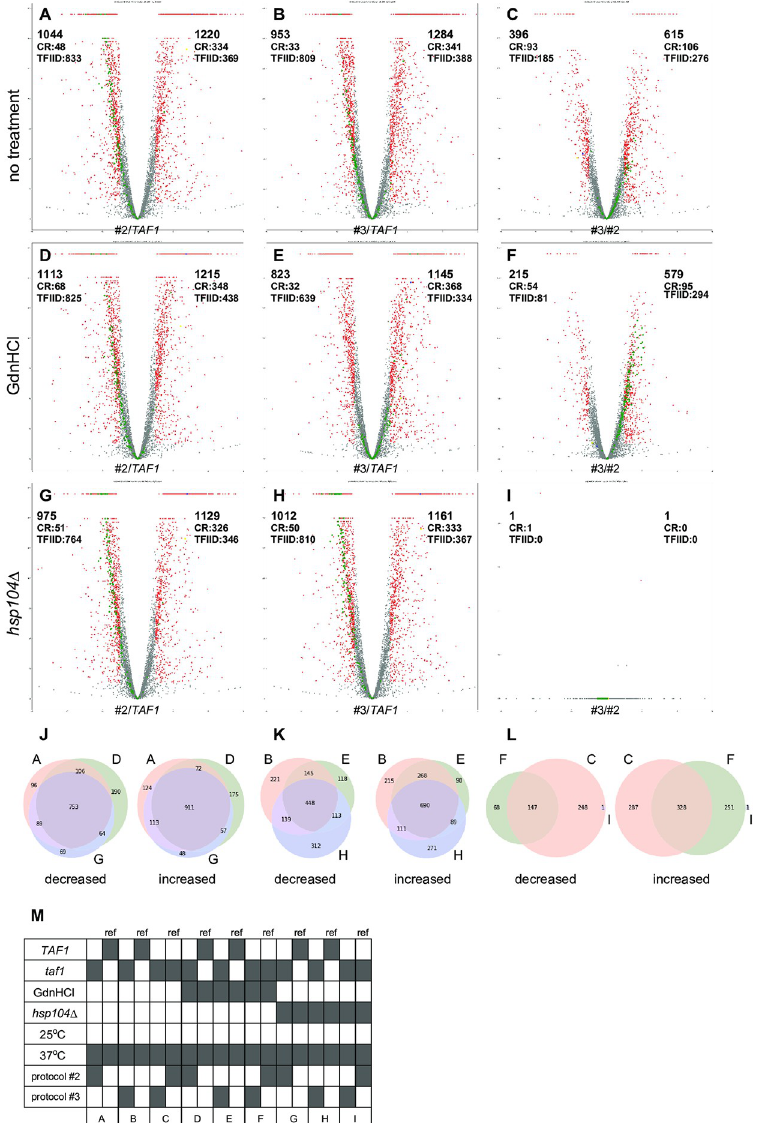
Fig 4. Volcano plot analyses of the gene expression profiles of #2 and #3 strains reveal HSP104 dependency of differential gene expression. TPM data of the RNA-seq analyses obtained from two biological replicates of six strains with and without taf1 or hsp104 Δ mutations after cultivation under various conditions, which are indicated in the bottom panel, were averaged and subjected to volcano plot analyses. Fold changes of gene expression in the #2 strain or #3 strain relative to that in the TAF1 strain are shown in A and B, respectively. Similarly, fold changes of gene expression in the #3 strain relative to that in the #2 strain are shown in C. The analogous three sets of comparisons were conducted for the TPM data derived from strains cultivated in the presence of Gdn-HCl (D, E, F) or the hsp104 Δ mutation (G, H, I). In A–I, the genes considered to be significantly differentially expressed ( > 2-fold change, p < 0.05) are indicated with red dots, while ribosomal protein genes, ~95% of which are TFIID-dependent genes [10], are indicated with green dots. Furthermore, the numbers of class II genes or those of the subclasses CR or TFIID- dependent, that were significantly differentially expressed, are shown in the upper left or upper right corners of A–I. The overlaps among these differentially expressed class II genes across A, D, and G (#2 strain versus TAF1 ), B, E, and H (#3 strain versus TAF1 ) and C, F, and I (#3 strain versus #2 strain) are visualized by Venn diagrams in J, K, and L, respectively. The cultivation conditions and comparison details for A-I are summarized in M. The strains used were YTK19317 (A, B, D, E), YTK19401 (A, C, D, F), YTK19489 (B, C, E, F), YTK20037 (G, H), YTK20038 (G, I), and YTK20049 (H, I). Cultivation was performed as described in Fig 1A and S4